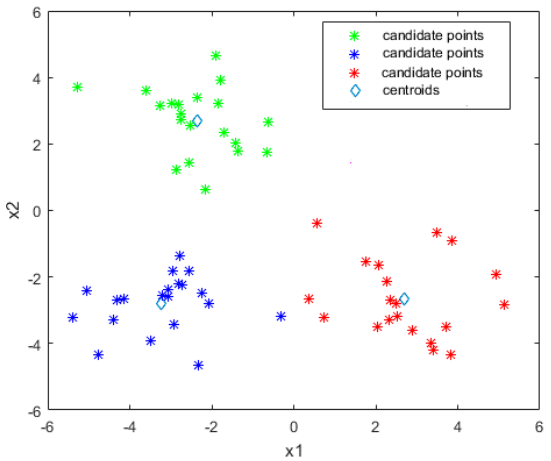
Figure 2. A 2D example of the k -means clustering technique.